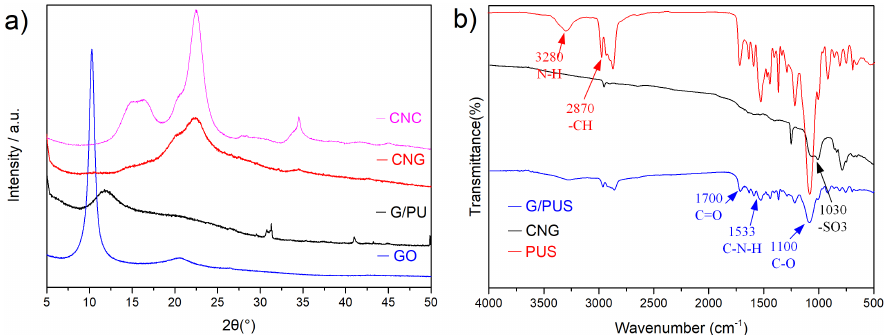
Figure 2. ( a ) XRD patterns of CNC, GO, G/PUS, CNG; and ( b ) FTIR spectrums of PUS, G/PUS,